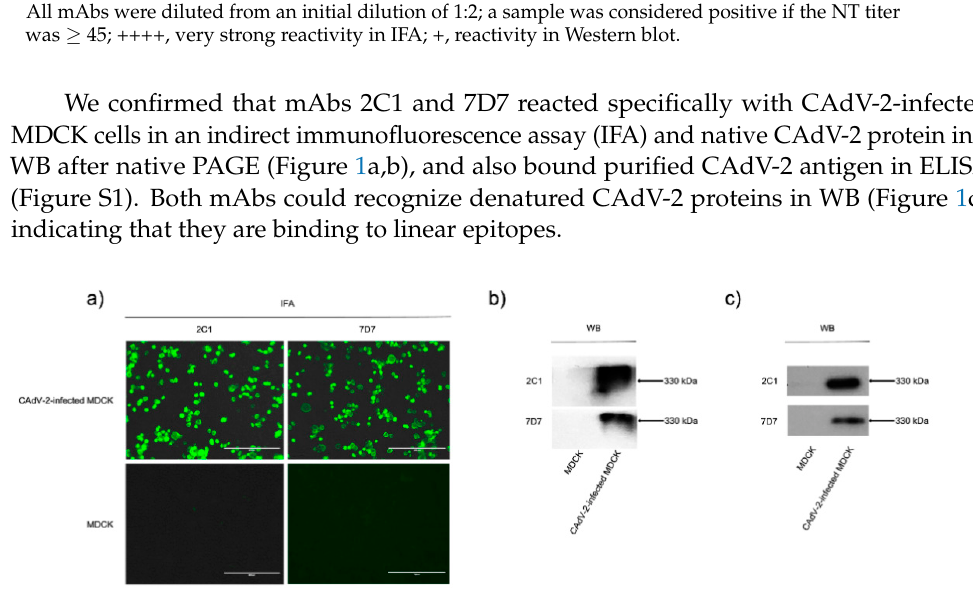
Table 3. Biological characterization of mAbs against CAdV ‐ 2.